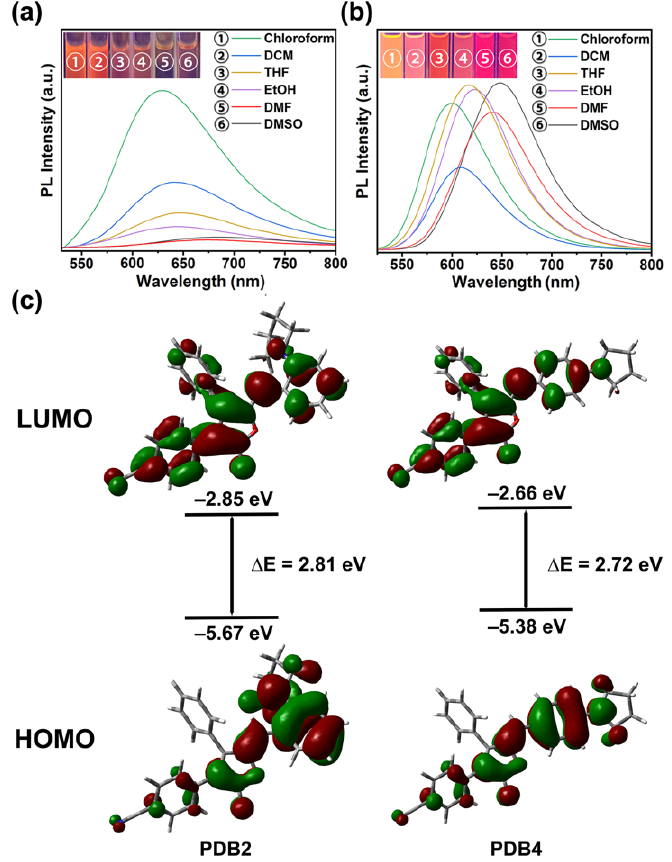
Figure 2. ( a ) Fluorescence spectra of PDB2 (50 μ M) in different solvents; ( b ) Fluorescence spectra of PDB4 (50 μ M) in different solvents. Inset: fluorescence images (Excited wavelength: 365 nm, 10 mM); ( c ) Calculation of the spatial distribution of HOMO and LUMO for PDB2 and PDB4 in DMSO.